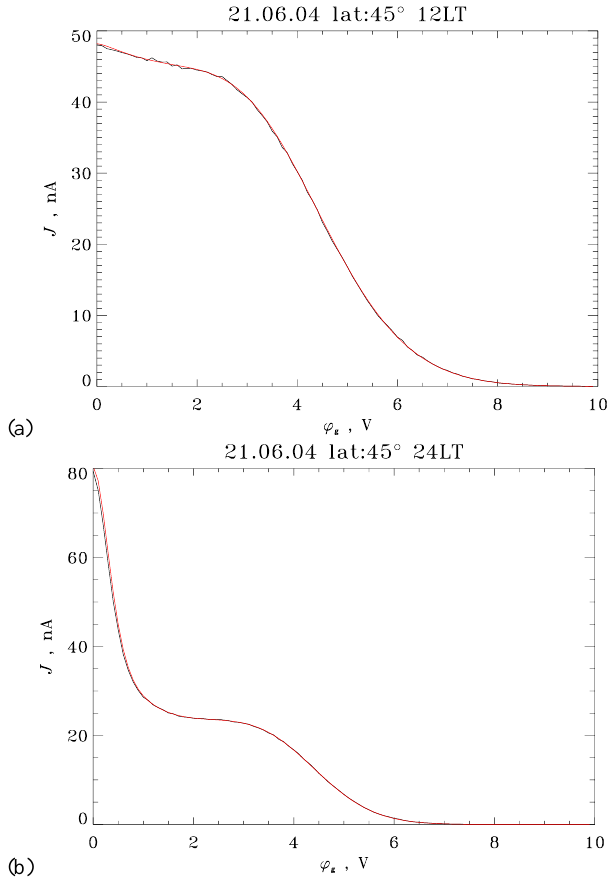
Fig. 3. Current-voltage response in the multi-species plasma for the conditions, as predicted by the IRI model on 21.06.04 at the altitude of 45 ◦ : (a) in sub-Sun point (12:00LT), with T i = 0 . 19eV, n O + = 3 · 10 10 m − 3 , n He + = n H + = 10 9 m − 3 , and (b) at midnight time (24:00LT) with T i = 0 . 09eV, n O + = 1 . 6 · 10 10 m − 3 , n He + = 4 · 10 9 m − 3 n H + = 3 · 10 10 m − 3 . The numerical solution is given by the black line and 1-D ∗ solution by the red line.